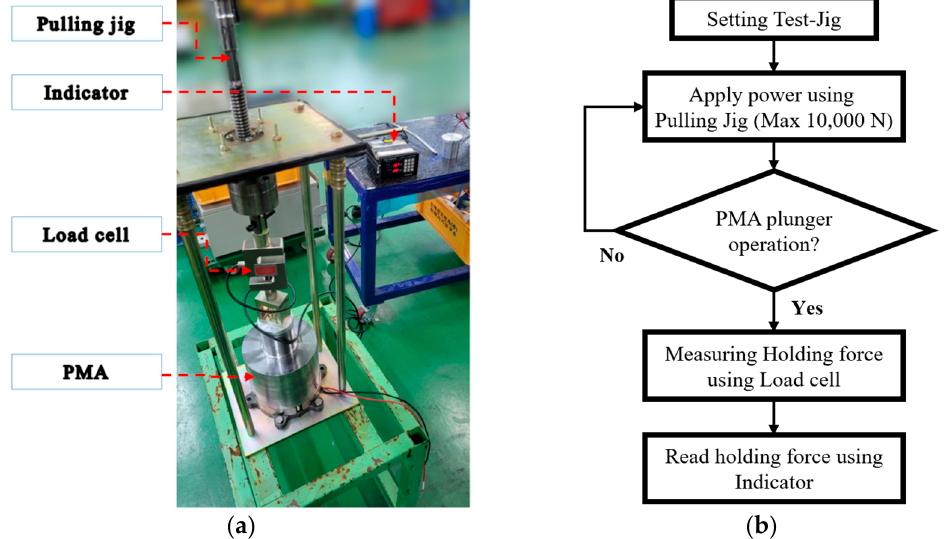
Figure 9. ( a ) Holding force measurement with prototype test-jig. ( b ) Flowchart of holding force measurement. Table 3. Analysis value and measurement value error.